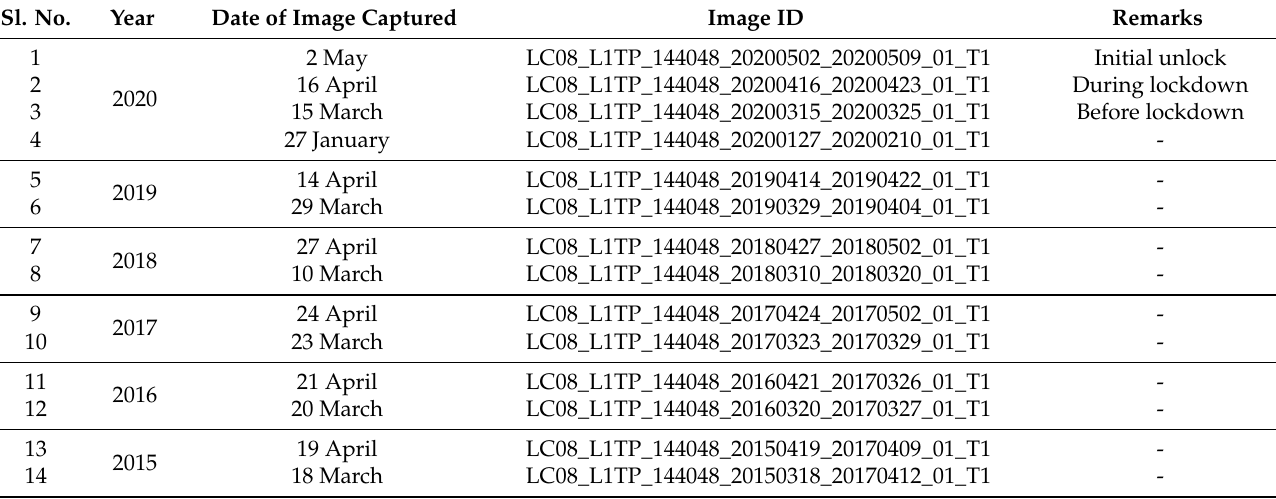
Table 4. Details of the Landsat 8 OLI images of lake Hussain Sagar used in this study covering Path 144—Row 48. Cloud-free satellite images are only selected in the analysis. No could-free satellite images were found in February 2020. For historical variations, only